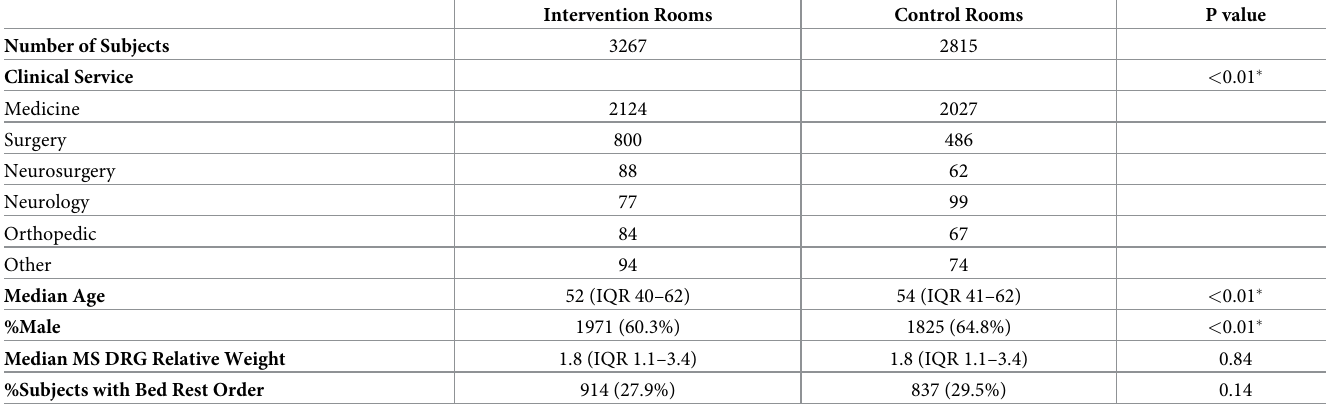
Table 1. Subject demographics (N = 6082).